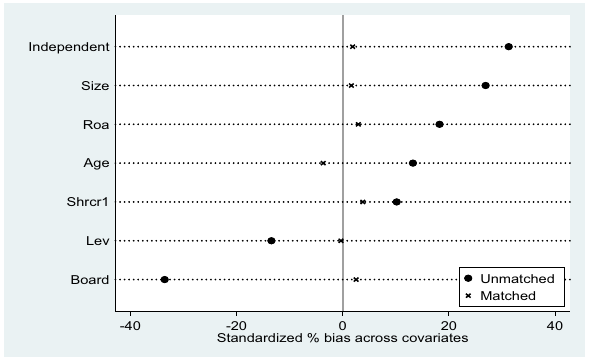
Figure 1. Propensity score matching test.